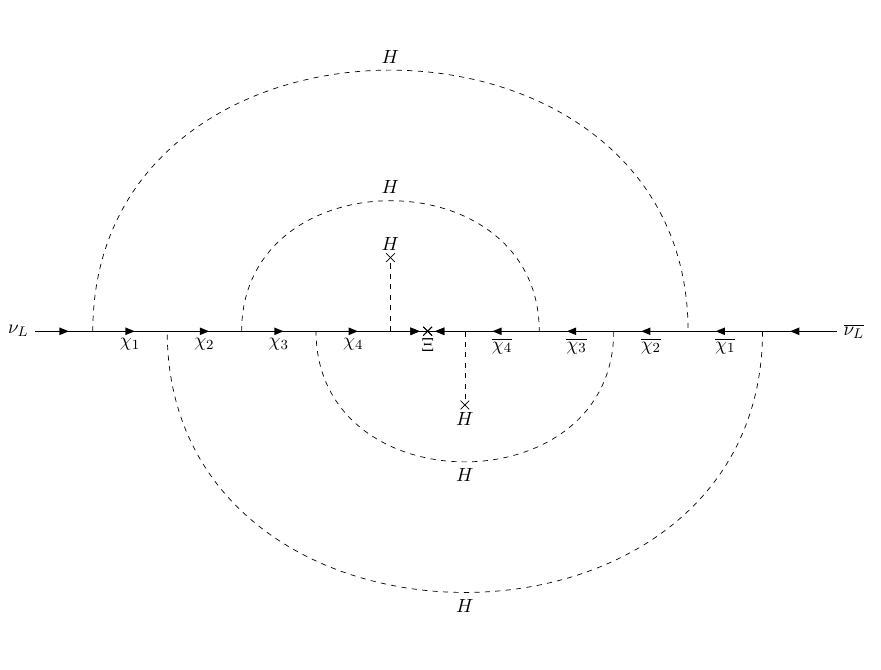
Figure 3 . “Chain” diagram for neutrino mass based on a model with the new fermions Ξ ∼ (1 , 7 , 0), χ 1 ∼ (1 , 3 , − 2), χ 2 ∼ (1 , 4 , − 1), χ 3 ∼ (1 , 5 , − 2), and χ 4 ∼ (1 , 6 , − 1). This is an example for a mechanism of systematic loop suppression of the neutrino